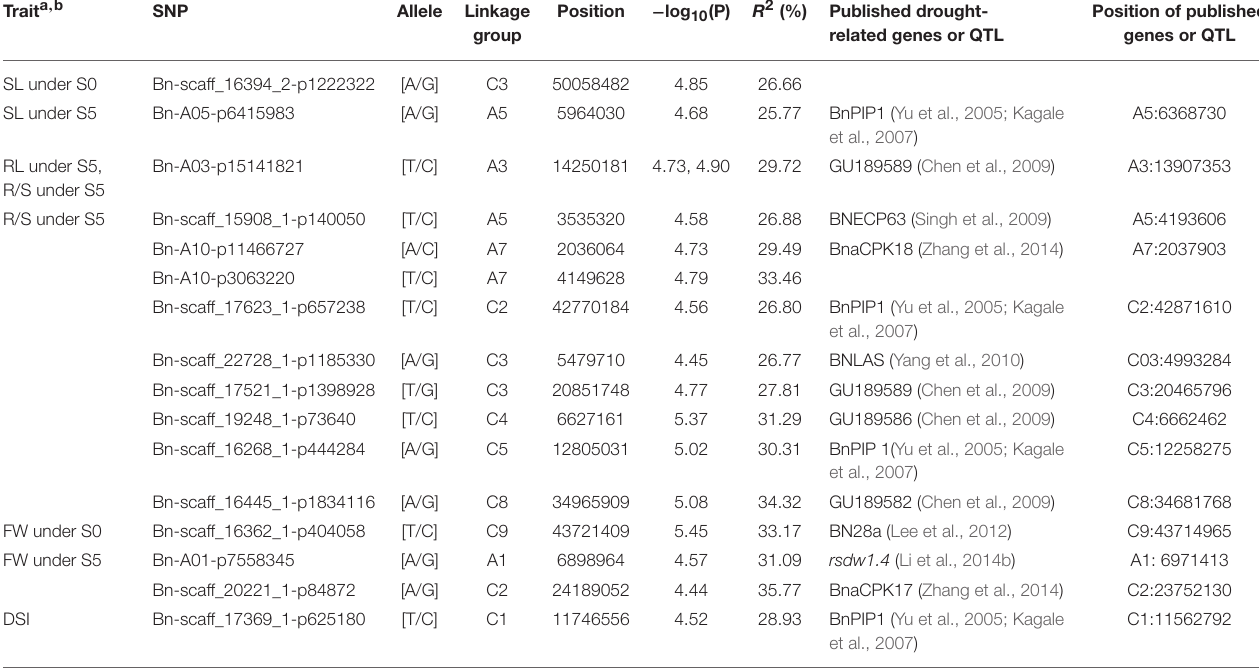
TABLE 3 | Leading genome-wide association SNPs for seedling traits under normal (S0) and water stress (S5) conditions. Trait a , b